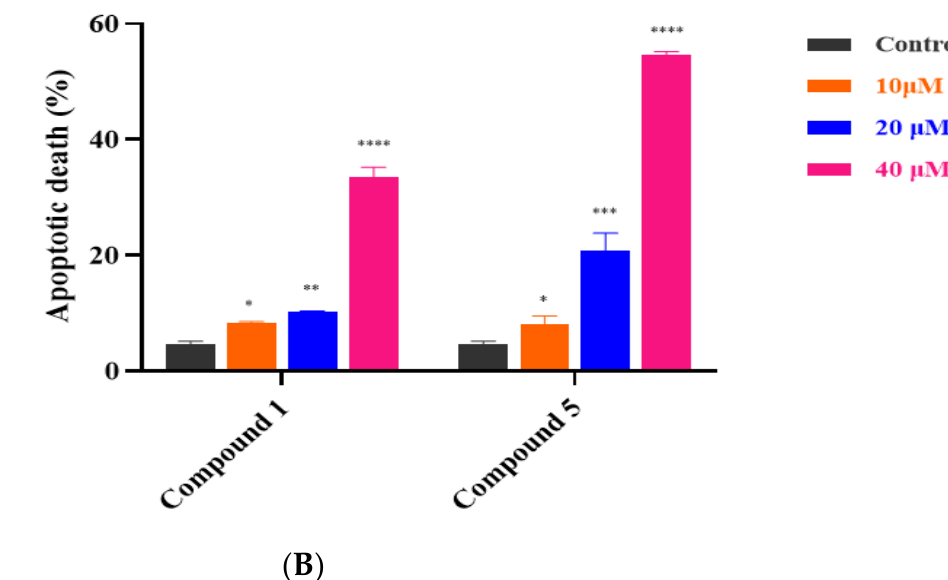
Figure 7. Apoptosis of RKO cells were induced by compounds 1 and 5 . ( A ) Cells were treated with 10, 20 and 40 μM for 48 h, respectively, then collected and dyed with Annexin V/PI and analyzed by flow cytometry. ( B ) Statistics of RKO cell apoptosis results. * p < 0.05, ** p < 0.01, *** p < 0.001, **** p < 0.0001, comparing with standard groups.